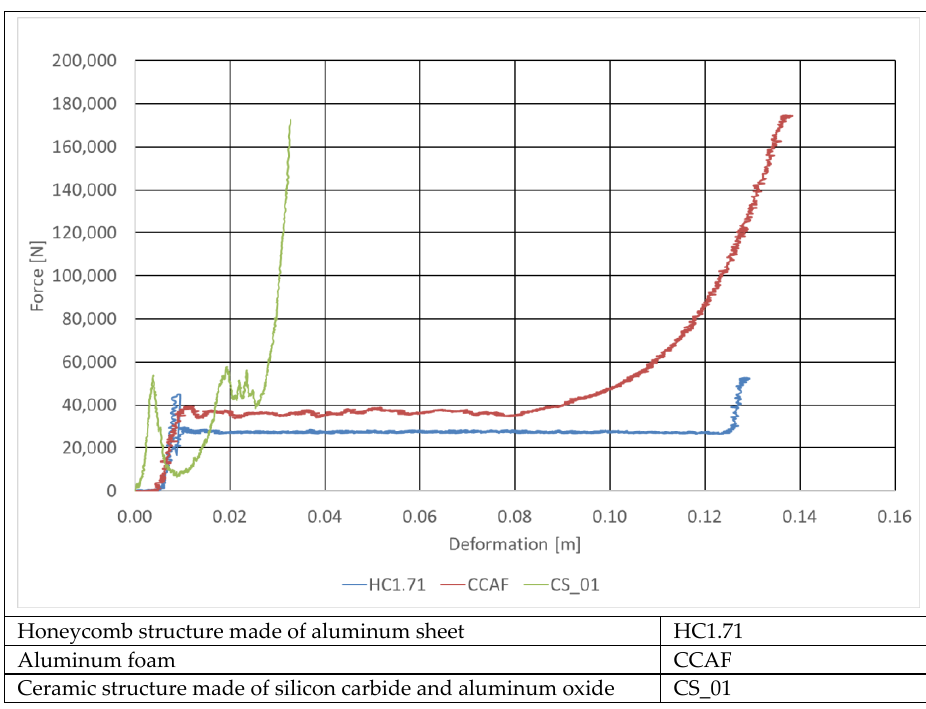
Figure 19. Stiffness characteristics of selected materials to be used as the absorber filling.